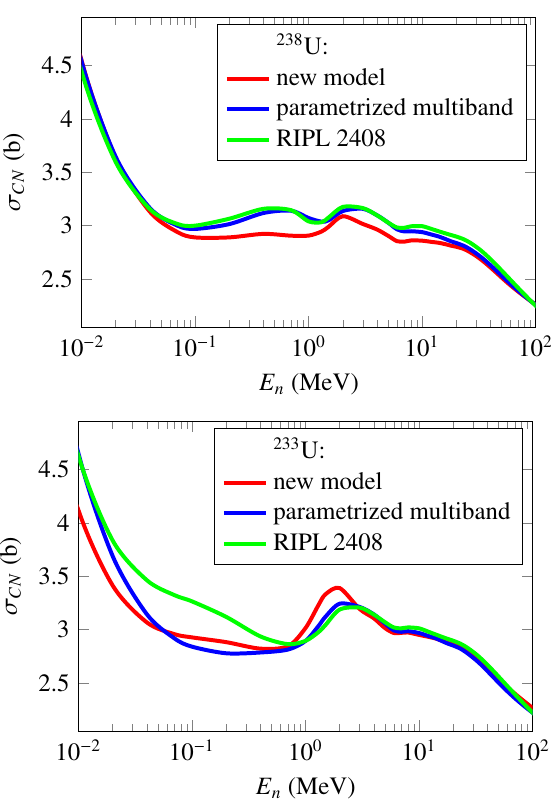
Figure 1. Calculated CN formation cross sections for neutron scattering on 238 U (top) and 233 U (bottom) using three Lane- consistent dispersive optical models: RIPL 2408 – rigid-rotor GS band coupling [12–14], multiband coupling with fitted “ef- fective” deformations [17], and current model with SRM-derived multiband